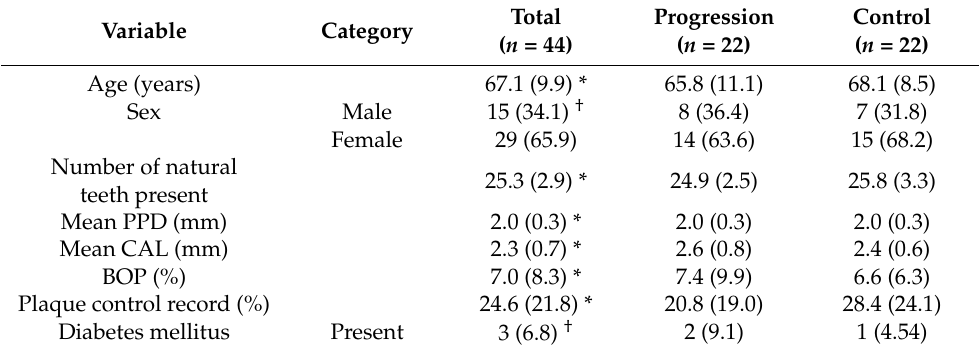
Table 1. Characteristics of participants at